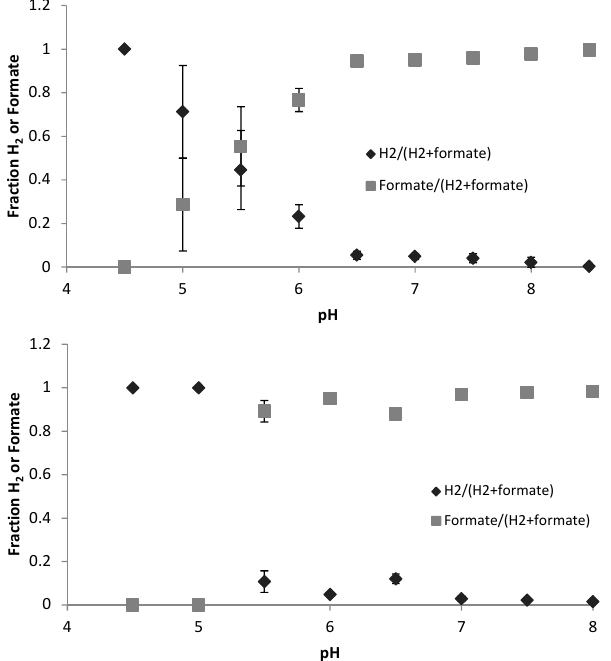
Figure 4. Influence of pH regulation approach on the hydrogen and formate produced as a function of pH in progressive pH approach (top) and reset pH approach (bottom). Ratio of H 2 to total H 2 and formate is indicated as dark diamond and ratio of formate to total of H 2 and formate is indicated as grey square.